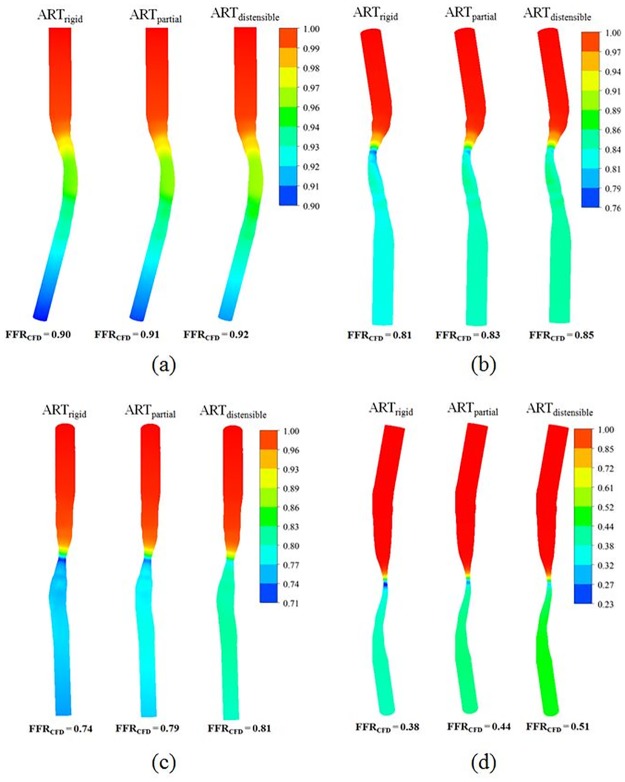
Effect of vessel rigidity on FFRCFD.FFRCFD for representative arteries with percentage diameter stenosis of (a) 40, (b) 50.5, (c) 62.5, and (d) 73 are shown.